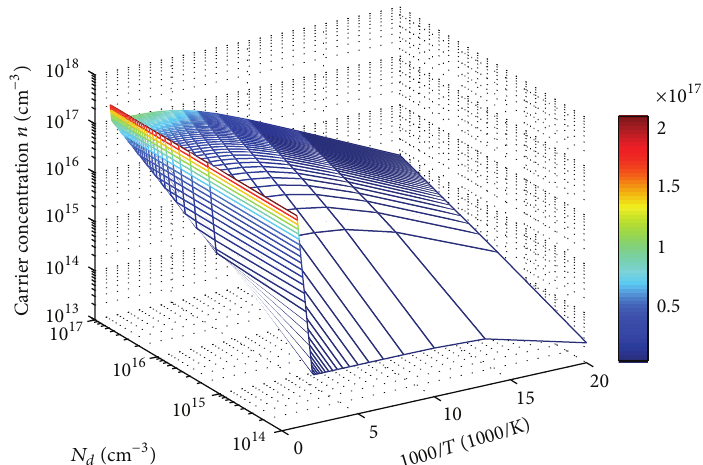
Figure 7: Graphical representation of carrier concentration 𝑛 versus reciprocal temperature and donor concentrations 𝑁 𝑑 .